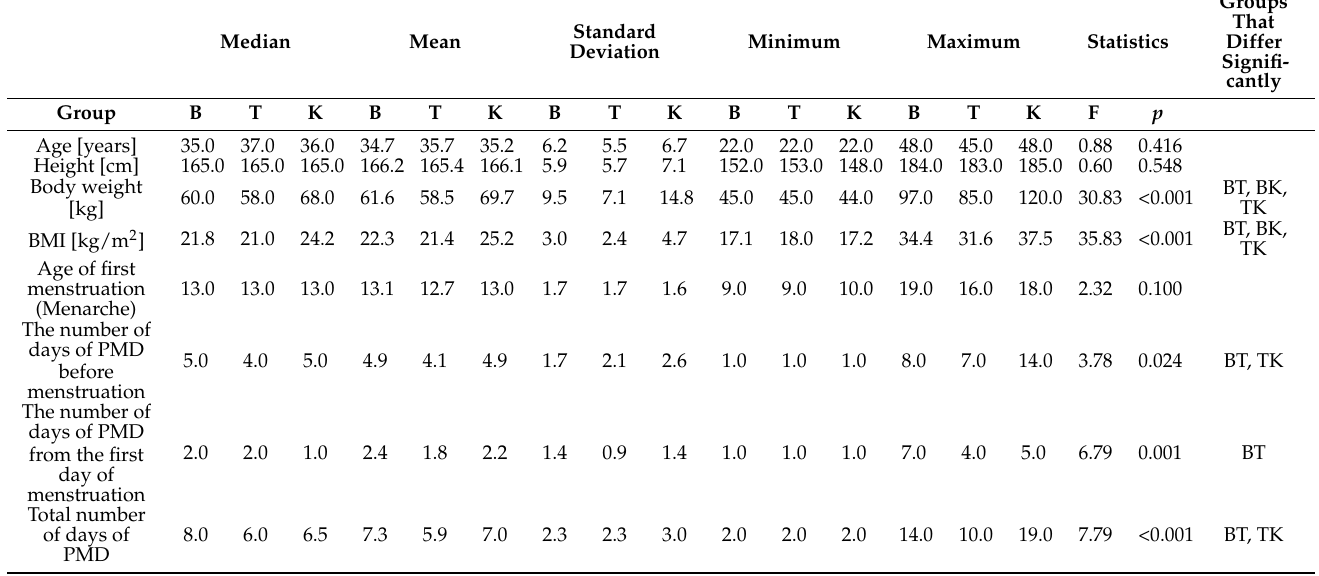
Groups That Differ Signifi- cantly